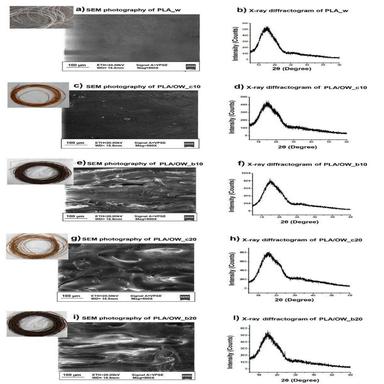
PLA wire, SEM photography with 500x magnification (a) and X-ray diffractogram (b) of PLA wire (PLA_w); PLA/OW_c10 wire, SEM photography with 500x magnification (c) and X-ray diffractogram (d) of PLA/OW_c10; PLA/OW_b10 wire, SEM photography with 500x magnification (e) and X-ray diffractogram (f) of PLA/ OW_b10; PLA/OW_c20 wire, SEM photography with 500x magnification (g) and X-ray diffractogram (h) of PLA/OW_c20; PLA/OW_b20 wire, SEM photography with 500x magnification (i) and X-ray diffractogram (l) of PLA/